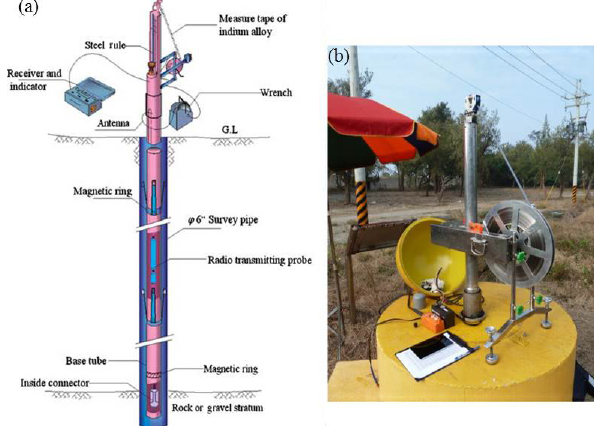
Figure 7. Sample pictures of a multi-layer compaction monitoring well.